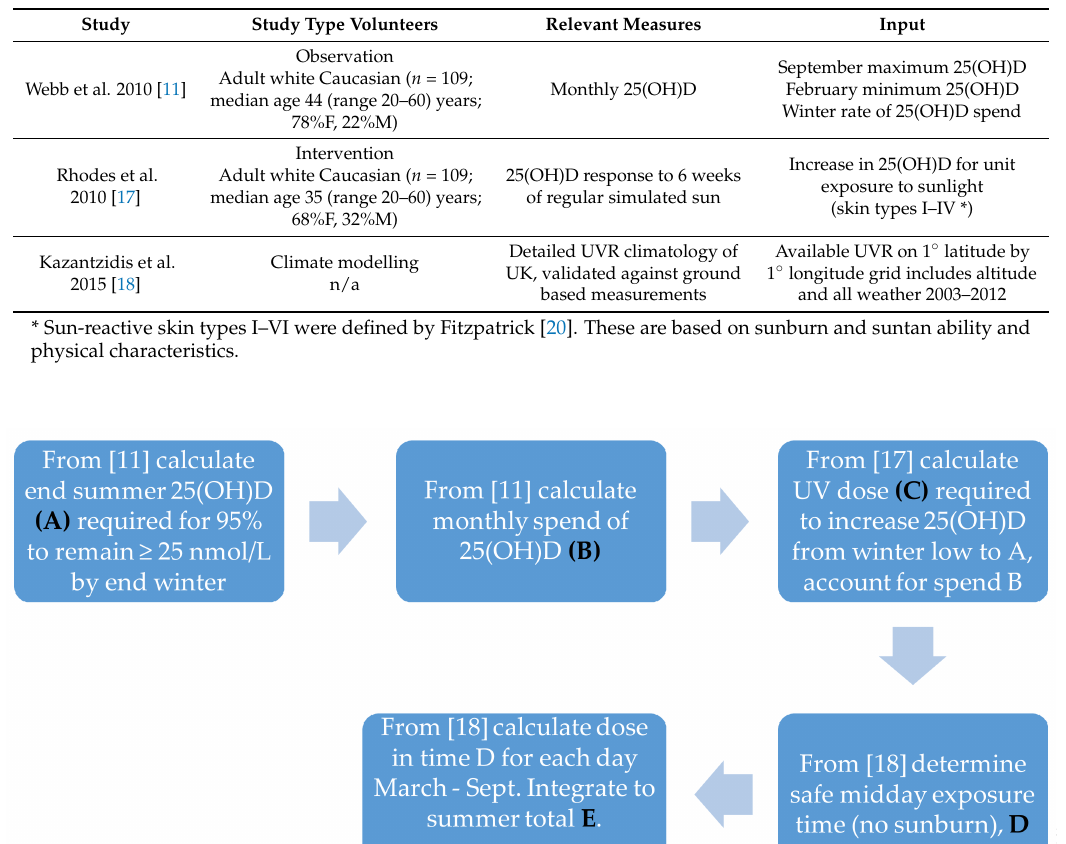
Table 1. The previous human in vivo studies that were incorporated into the calculation of required UK summer sunlight exposure and the information they provided.